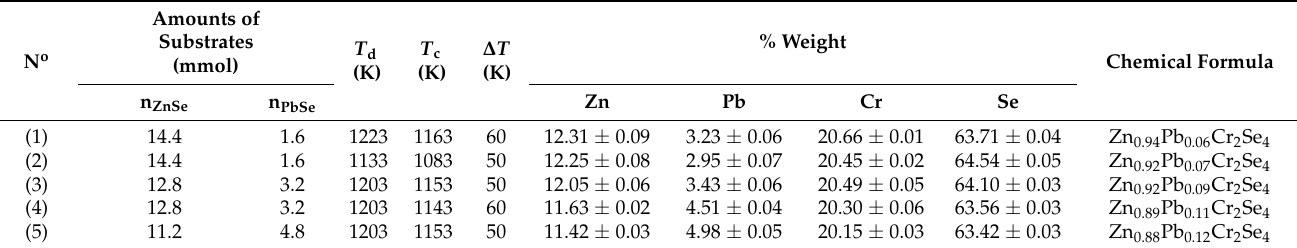
Table 1. Conditions of growth and chemical composition of ZnCr 2 Se 4 :Pb single